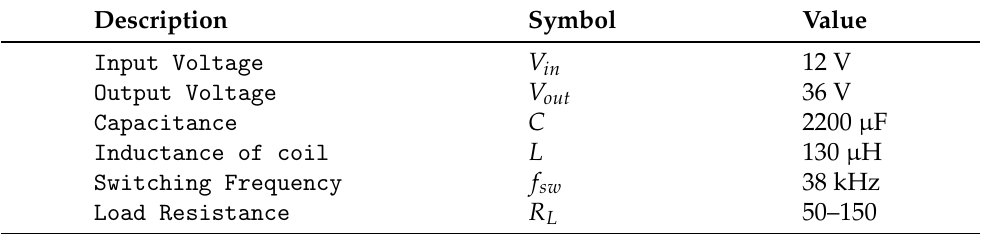
Table 1. Parameters of DC